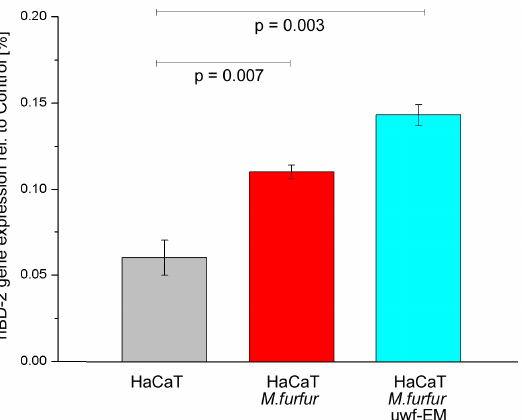
Figure 4. hBD-2 gene expression of HaCaT cell cultures after 24 h of incubation. The figure shows the control (grey), the batch infected with M. furfur (red), and the batch infected with pre-treated M. furfur that underwent uwf-EM exposure (blue). For further details, see the Methods section. The calculated p -values ( p < 0.05) highlight the statistical significance of the obtained results. Table 4. Numeric representation of the antimicrobial peptide compared to the control as averages of three replicates along with the corresponding standard deviations.